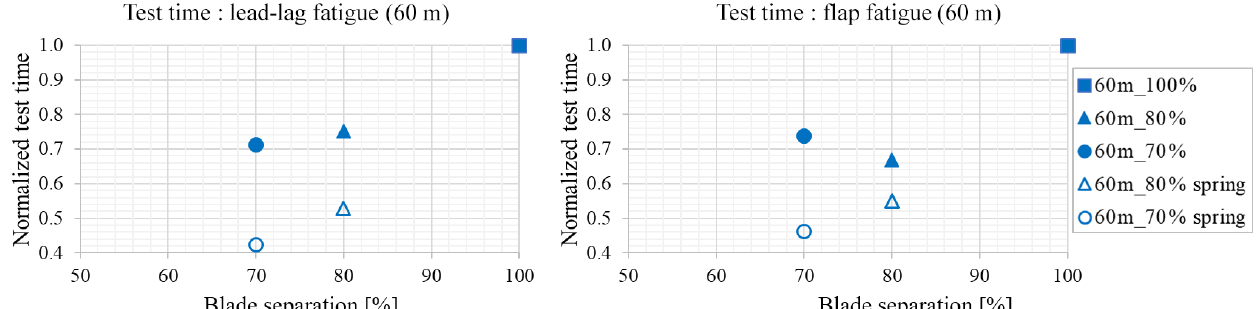
Figure 11. Effect of spring elements on fatigue test time of 60m blade root